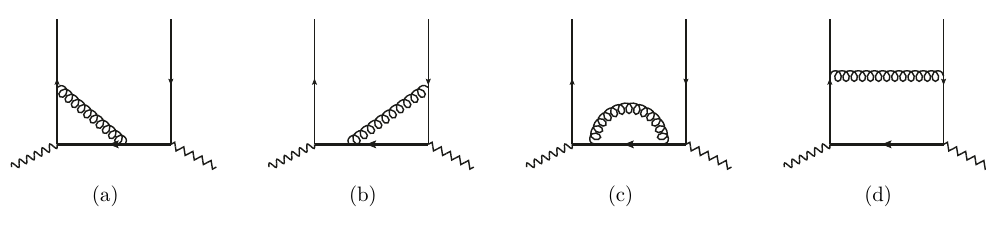
Figure 3 . Diagrammatic representation of the four-point QCD matrix element F (cid:22) ( p; q; u ) de(cid:12)ned by (3.1) at one